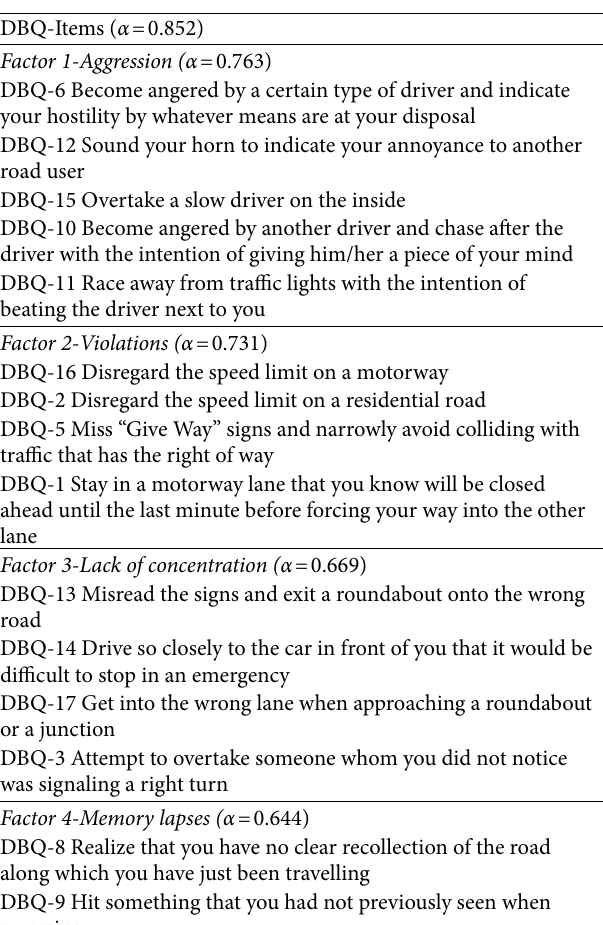
Table 2: DBQ used in this study. Table 3: DSI used in this